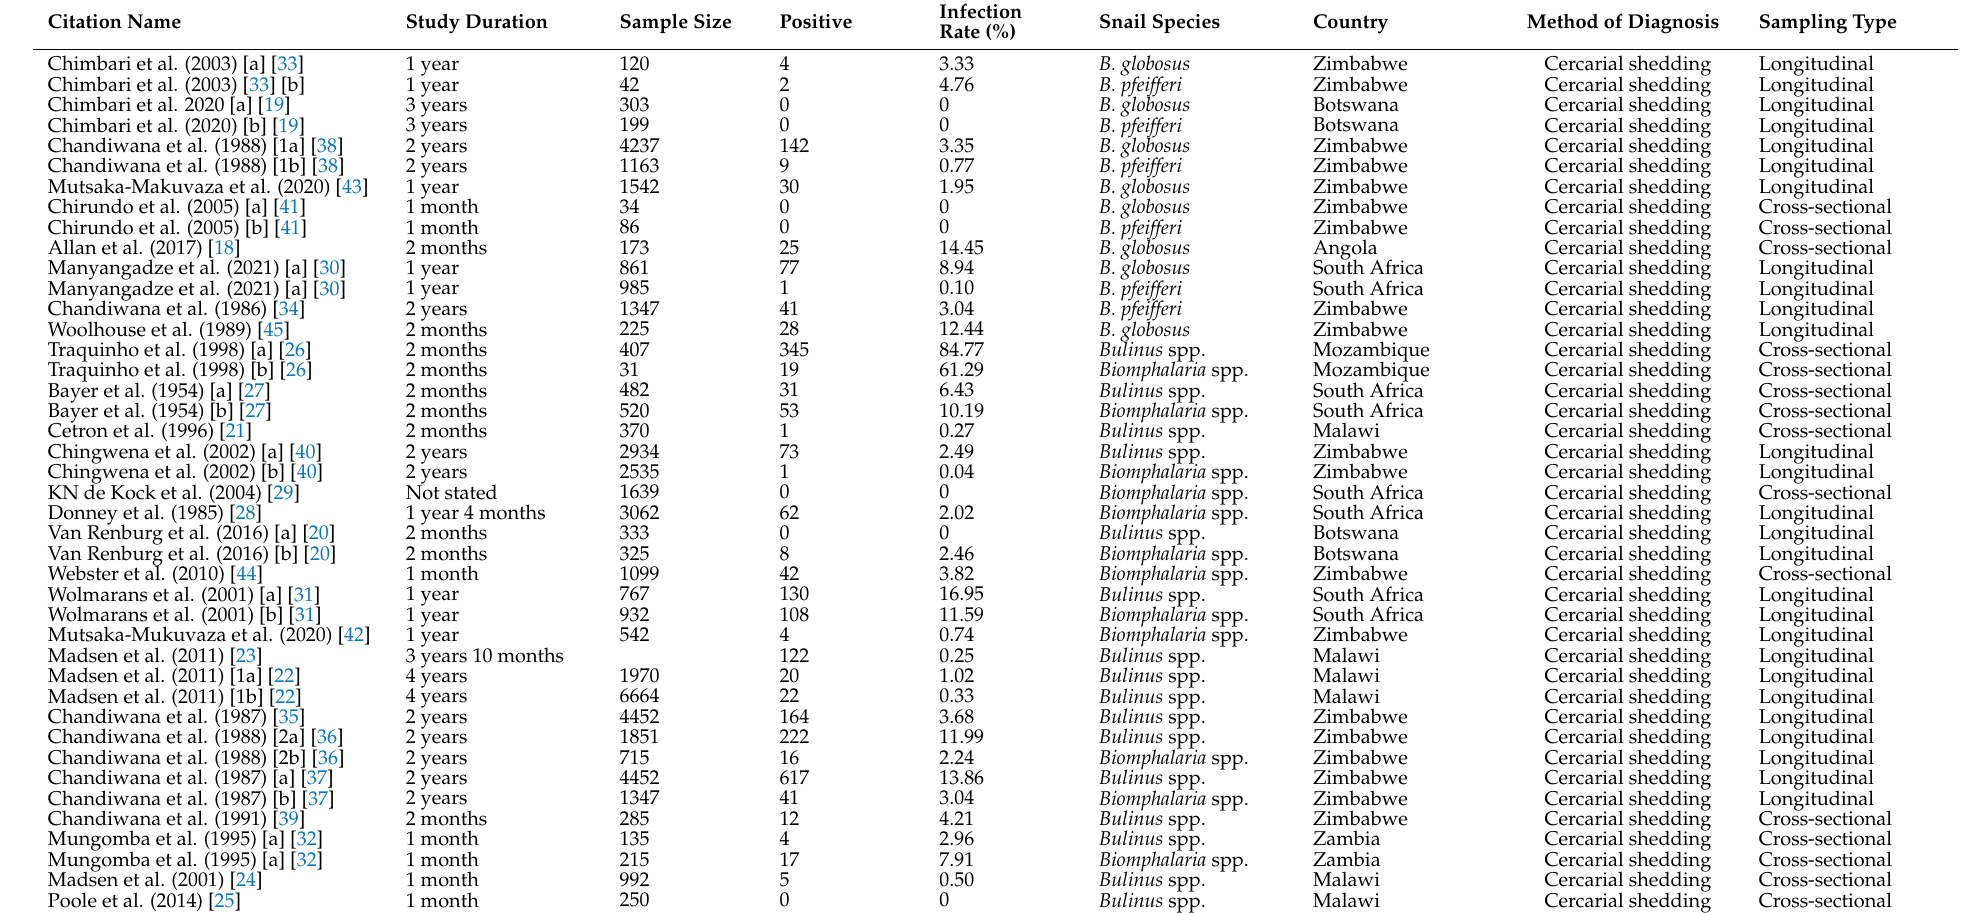
Table 1. Summary of eligible studies included in the